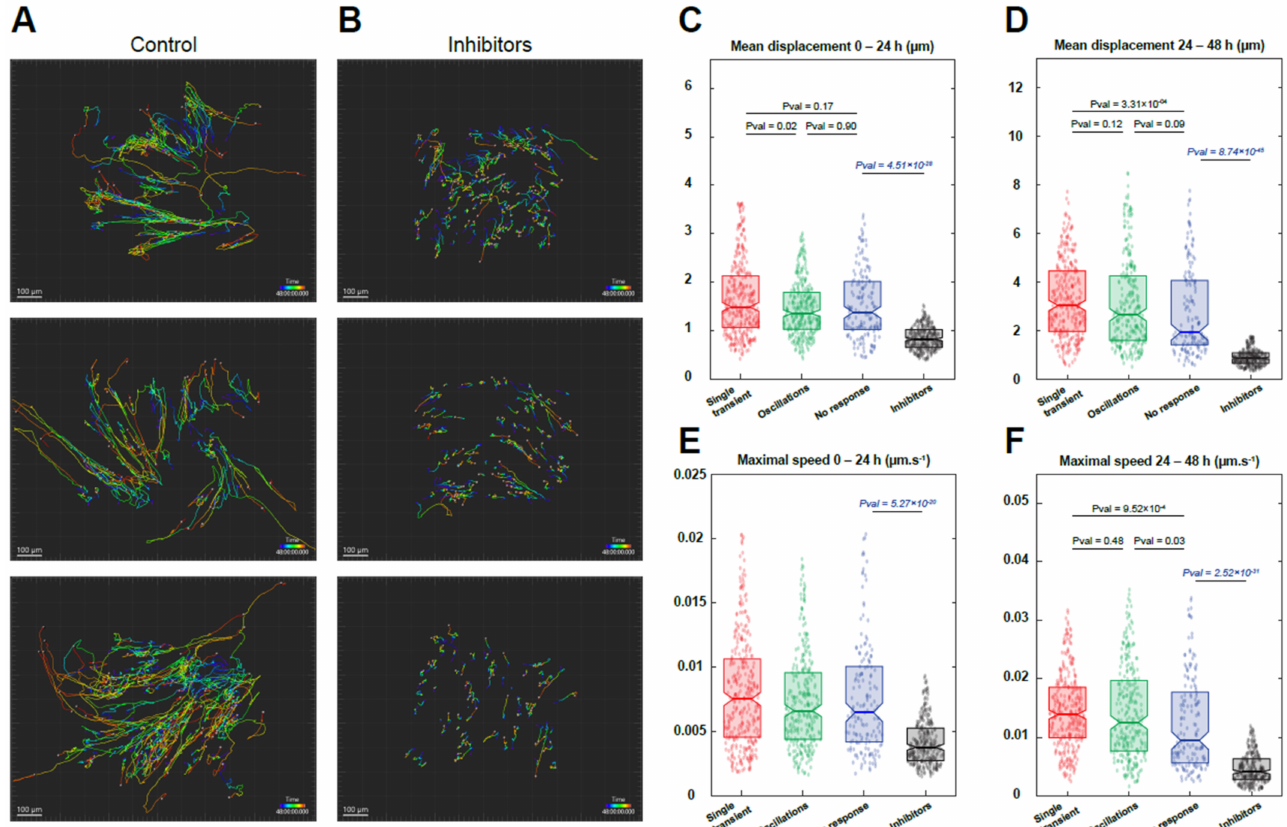
Figure 7. Migration of reserve cells. Myoblasts were differentiated for 48 h to obtain myotubes and RC. Cells were loaded with Cal520 to evaluate their Ca 2+ response induced by serum and stained with SPY650-DNA to label the nuclei (see Materials and Methods for details). Ca 2+ responses were recorded for 10 min, followed by timelapse imaging of 48 h to track the migration ( A ). For comparison, stimulation with YM254890 and GSK7975a (inhibitors) was performed ( B ). Mean displacement (dis- tance between two time points separated by 15 min) of cells at 0–24 h ( C ) and 24–48 h ( D ), according to their Ca 2+ response and compared with the condition in the presence of inhibitors. Maximum speed of cells at 0–24 h ( E ) and 24–48 h ( F ) depending on their Ca 2+ response and compared with the condition in the presence of inhibitors. Statistics for “no response”, “single transient”, and “oscillations” were calculated with a Kruskal–Wallis test and multiple comparisons. Inhibitors were compared to “no response” with a Mann–Whitney test. The movement of 300–877 cells was followed from one (condition with inhibitors) to three independent